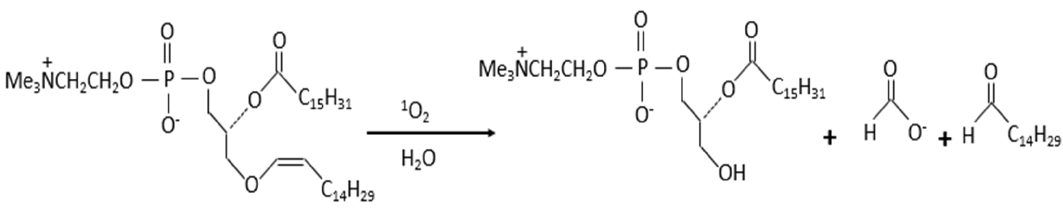
Figure 4. Photo ‐ oxidation of plasmalogen at the vinyl ether linkage mediated by singlet oxygen. Figure 4. Photo-oxidation of plasmalogen at the vinyl ether linkage mediated by singlet